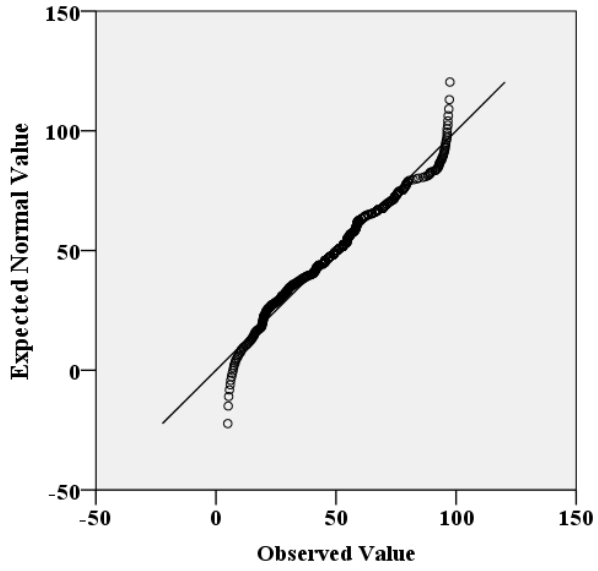
Figure 6. Q-Q plots were constructed to test for the normal distribution of droplet